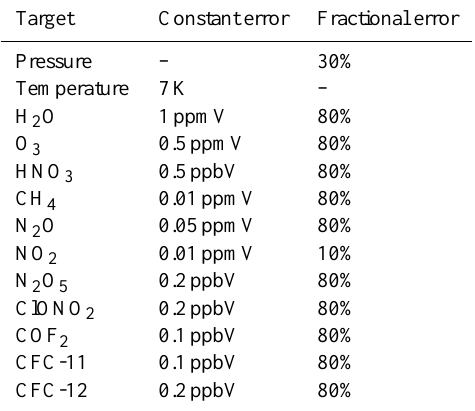
Table 1. Size of the a-priori errors used in the